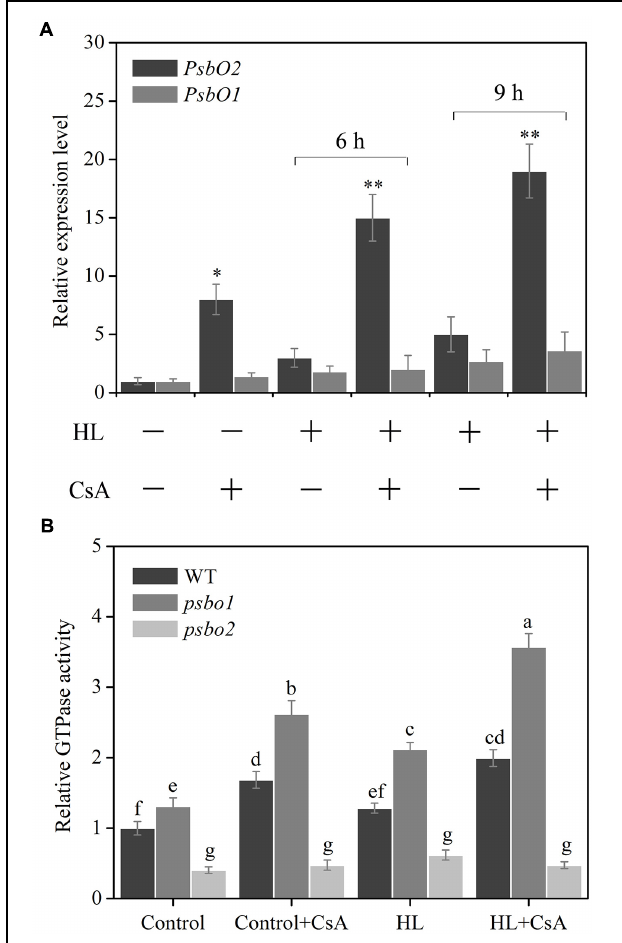
FIGURE 5 | Effect of CsA on HL-induced PsbO gene expression and its GTPase activation in Arabidopsis . (A) qRT-PCR analysis of PsbO1 and PsbO2 gene expression in CsA-pretreated detached leaves of WT plants after HL treatment. Total RNAs were extracted from the HL-treated detached leaves at the indicated time for the qRT-PCR analysis. (B) GTPase activity analysis using CsA-pretreated PSII membranes of WT, psbo1 and psbo2 after HL treatment. Detached Arabidopsis thaliana leaves or PSII membranes were pre-incubated with or without CsA (10 µ M), and then treated with HL. WT GTPase activity at control light was set to 1. Different letters indicate statistically signifcant differences between treatments (Duncan’s multiple range test: P < 0.05). Asterisks ( ∗ ) indicate a significant difference from the Control at ∗ P < 0.05, ∗∗ P <